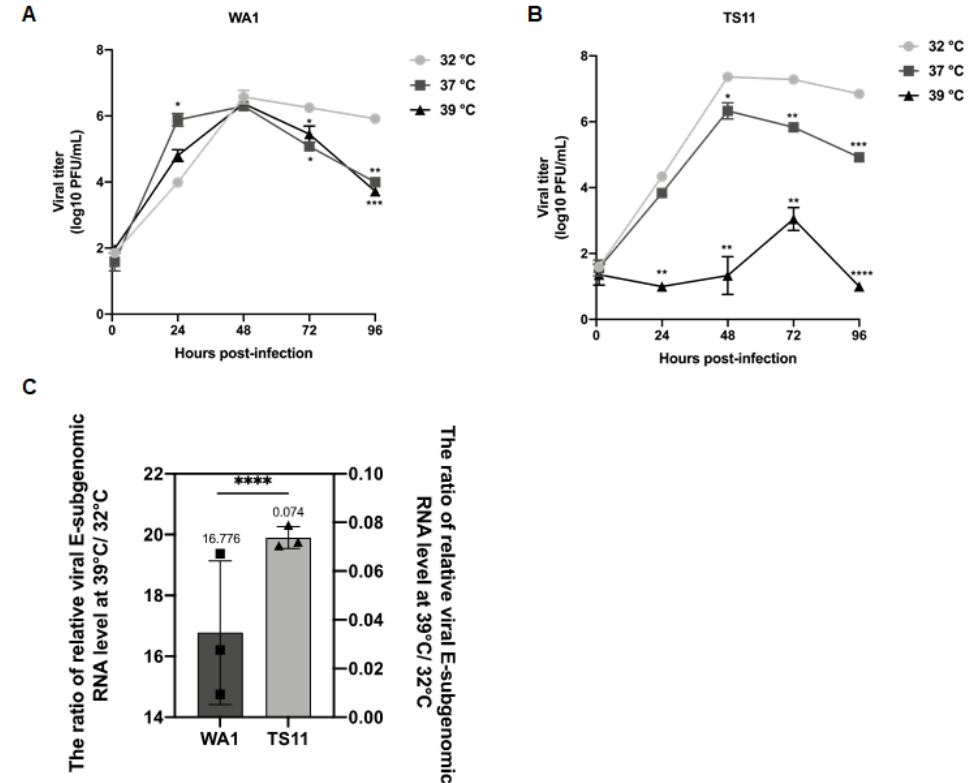
Figure 2. Characterization of the SARS-CoV-2 TS11 in Vero E6 cells. Multi-step growth kinetics of SARS-CoV-2 WA1 ( A ) and SARS-CoV-2 TS11 ( B ) at 32 °C, 37 °C and 39 °C. Vero E6 cells were inoculated with SARS-CoV-2 WA1 and SARS-CoV-2 TS11 at a MOI of 0.01 at 32 °C, 37 °C or 39 °C. Infected cells were harvested at the indicated time points, and virus titers were determined by plaque assays. The ratio of relative viral E subgenomic (+) RNA level at 39 °C:32 °C ( C ). Vero E6 cells were infected with SARS-CoV-2 WA1 or TS11 at an MOI of 1.0 at 32 °C for 1 h. After removing the virus inoculum and washing cells, the plates were cultured at 32 °C or 39 °C for an additional 7 h. Total RNA was extracted from the infected cells, and the relative levels of SARS-CoV-2 E gene subgenomic (+) RNA were determined by reverse transcription followed by quantitative PCR using actin gene as an internal control. The data are presented as mean ± standard deviation of triplicates. At each time point, data were analyzed by one-way ANOVA followed by Dennett’s test by comparing data of each group with values at 32 °C (*, p < 0.05; **, p < 0.01; ***, p < 0.005; ****, p < 0.001).